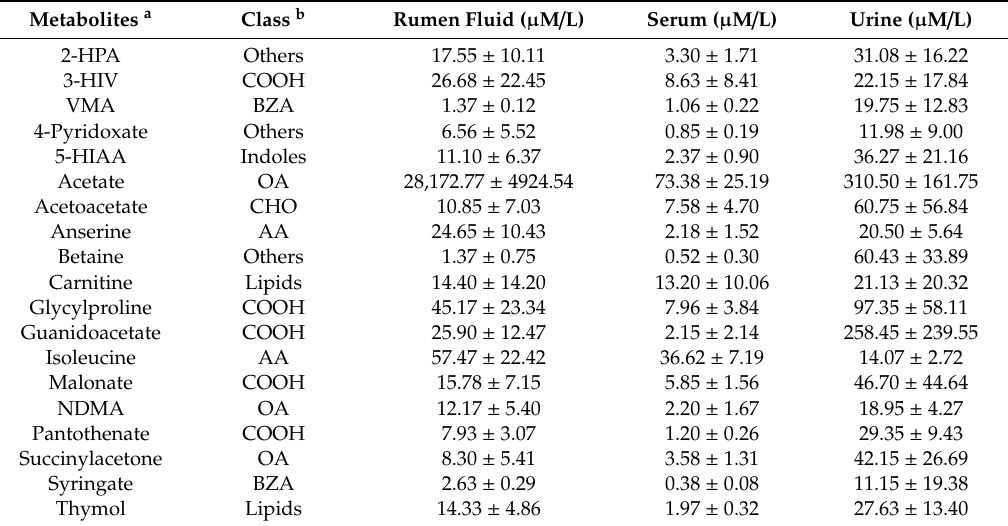
Table 4. Concentration (mean ± standard deviation) of common metabolites quantified ( n ≥ 4) in three biofluids by 1 H-NMR spectroscopy of Hanwoo